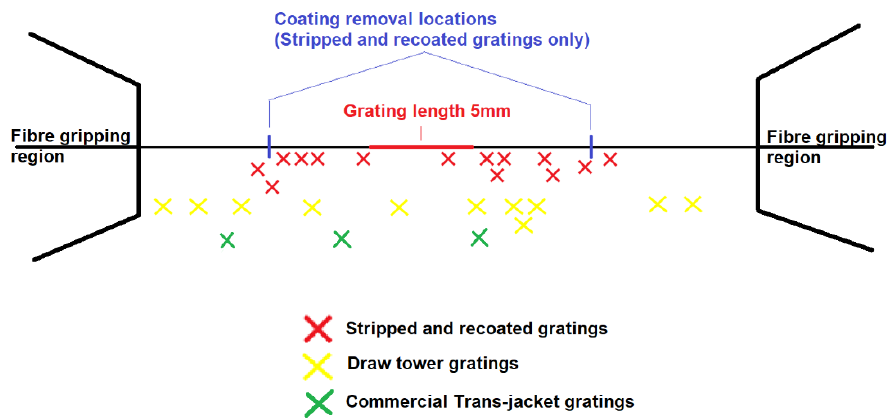
Figure 6. Range of fatigue failure strains for stripped and recoated FBGs.